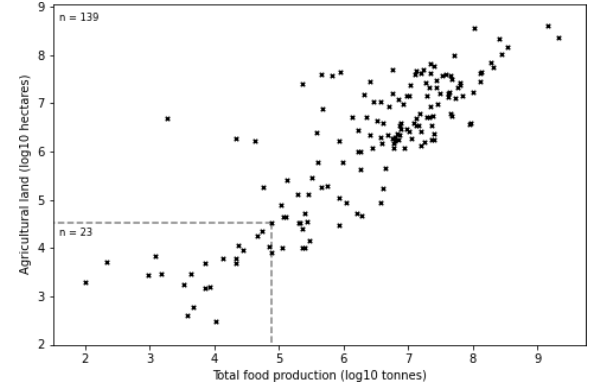
Figure A2. Log of agricultural land area against total food pro- duction mass for the year 2017 for all countries in the FAOSTAT database; dissolved states are not included. Countries contained in the small dotted-line box are not included in model processes ( n = 23), while the remaining countries are included ( n =